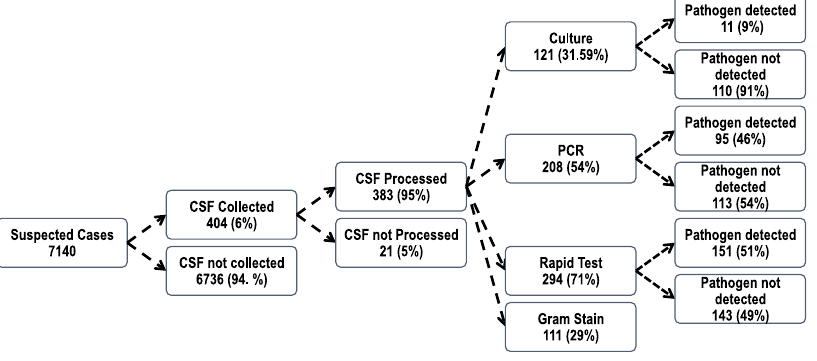
Figure 1. Summary of CSF specimen collection and processing in Zamfara